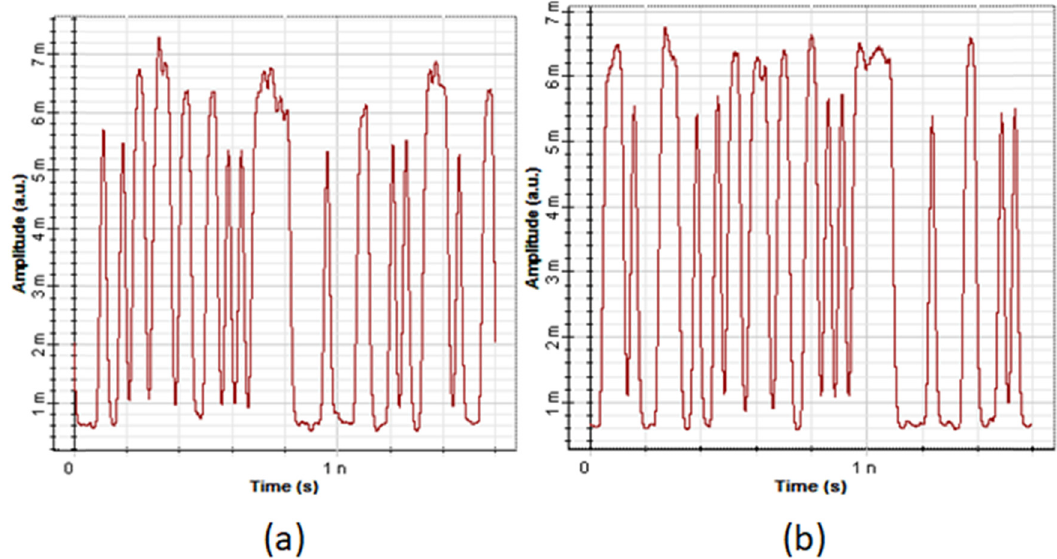
Figure 6: Amplitude vs time directly after Photodetector ( PIN ) at the side receiver for drop: ( a ) signal_1 = 193.1 THz and ( b ) signal_4 = 193.4 THz @span = 200 km, and bitrate = 40 Gbps.